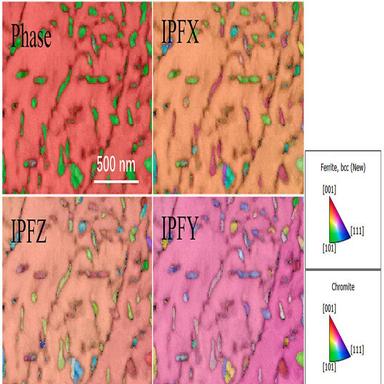
TKD analysis results for phase map at the matrix-internal oxide layer interface of T91 after exposure in SCW at 600 ◦C for 100 h.